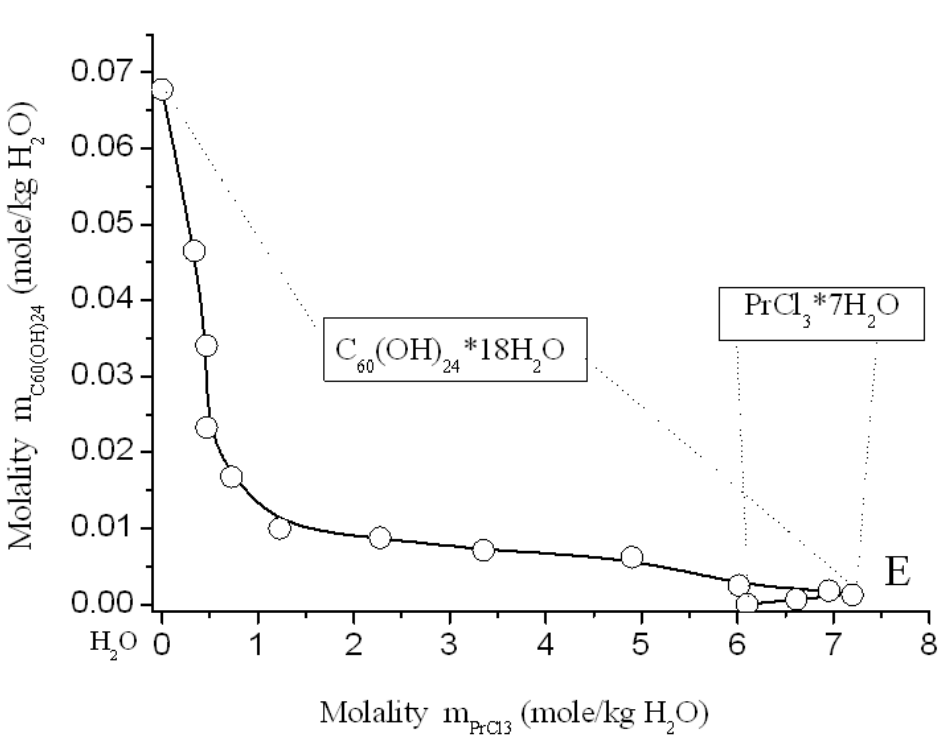
Processes 2021 , 9 , x FOR PEER REVIEW Figure 7. Solubility diagram in ternary system C 60 (OH) 24 —PrCl 3 —H 2 O at 25 ◦ C. Figure 7. Solubility diagram in ternary system С 60 (ОН) 24 —PrCl 3 —H 2 O at 25 °C.